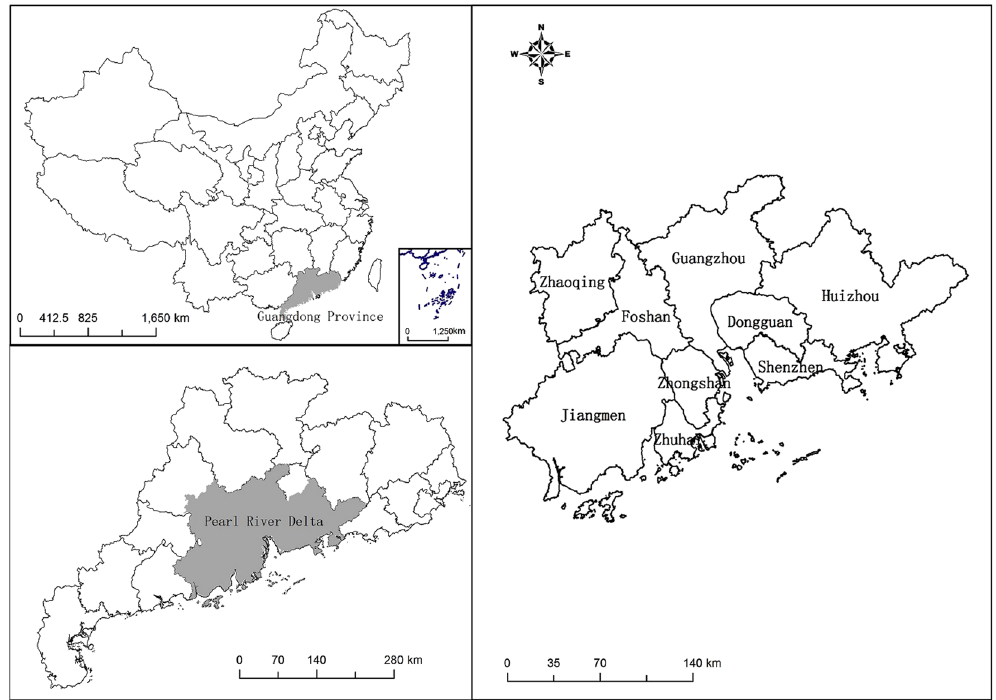
Figure 3. Location of the study area. Map created using ArcMap (version 10.2) software, (http://www.arcgis. com/). (Scientific Reports remains neutral with regard to jurisdictional claims in published